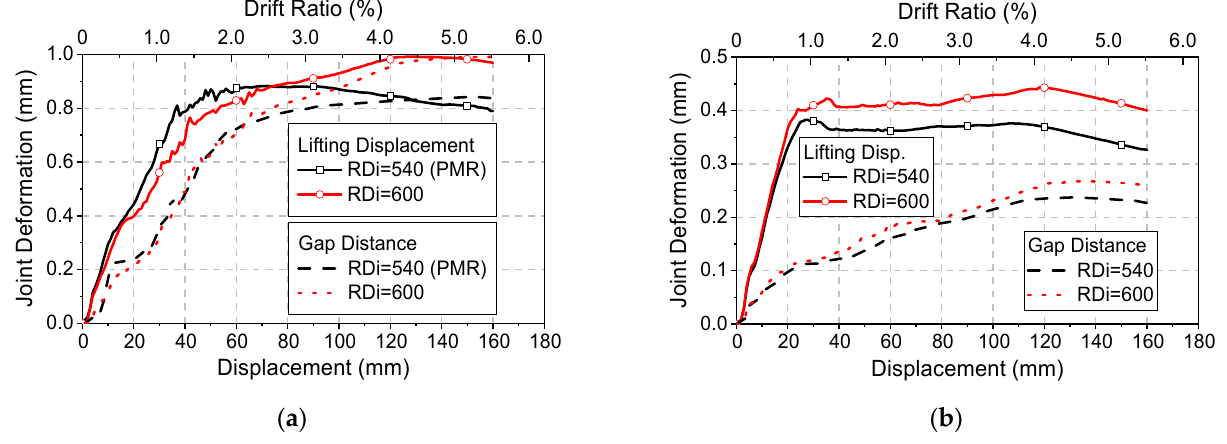
Figure 27. Joint deformation with different recess diameters: ( a ) shallow recess (RDe = 50 mm, CT = 20 mm); ( b ) deep recess (RDe = 100 mm, CT = 20 mm). Variations of maximum mortar stress are shown in Figure 28. Little change is found with diameter increase for shallow recess, and concrete of the footing exceeds its ultimate strength at peak stress of mortar. However, stress level is reduced for deep recess by 11% for the two different RDi values in the case of deep recess, and no local compressive damage at footing concrete is found. As the strength of mortar is higher than concrete, stress is more uniformly transferred from thicker mortar, preventing concrete from local failure. The maximum stress values at displacement level of 160 mm are close (33.60 MPa and 33.44 MPa, respectively) in the case of shallow recess. Larger RDi moves compressive stress of the rim closer to the near side, giving better column support and pry-out restriction. Therefore, stiffer and higher strength boundary around the column bottom is recommended.